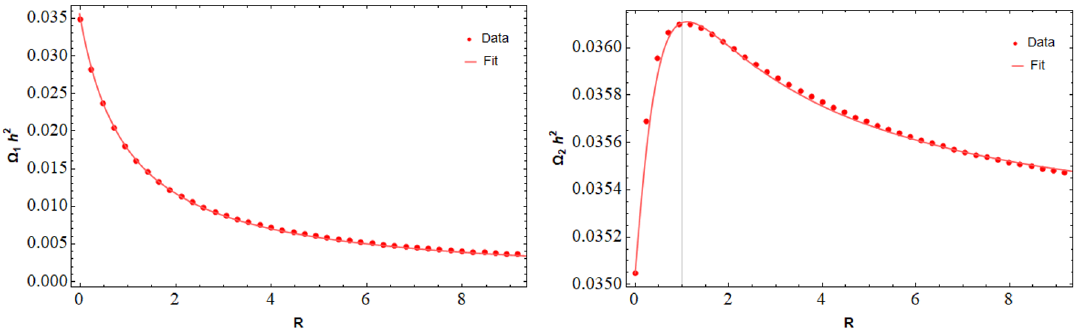
Figure 10 . Abundance of the heaviest ( left panel ) and the lightest component ( right panel ) versus R = h σ for the case of mass-independent cross-sections with N = 2 , conv , 12 v i / h σ ann , 1 v i h σ ann , 1 v i = h σ ann , 2 v i = 5 . 85 × 10 − 9 GeV − 2 , m 1 = 40 GeV and m 2 = 20 GeV. The data is fitted with eq. (5.9), with α = 9 . 38 × 10 − 5 , β = 1 . 65 and γ = 0 . 77 . The peak close to R ’ 1